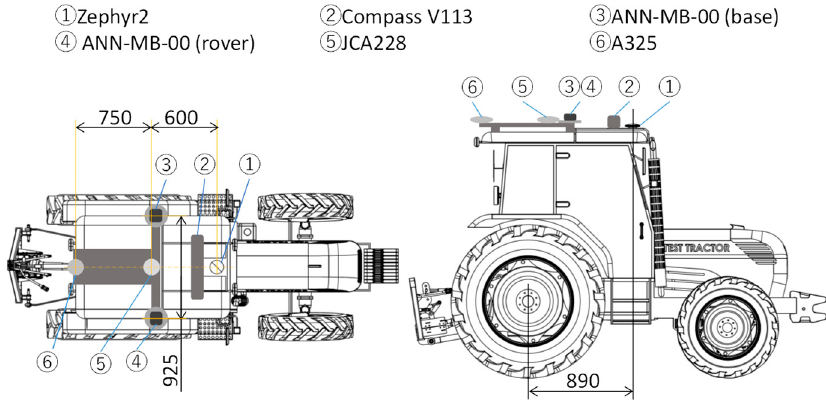
Figure 1. Outline of GNSS antennae mounted on the carrier vehicle.